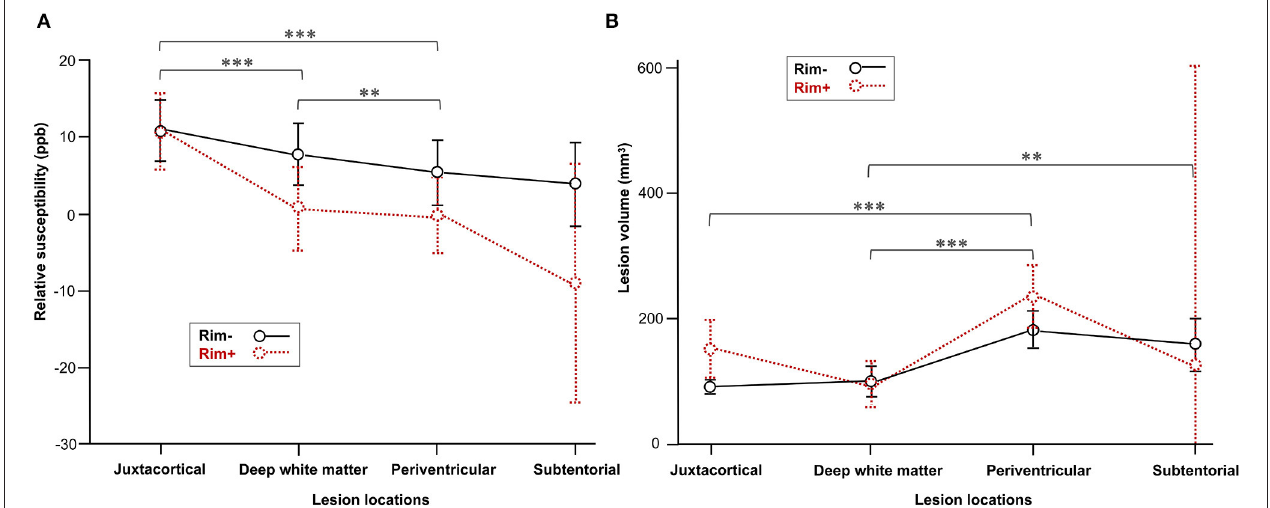
FIGURE 2 | Comparison of MS lesions in different locations. (A) Lesion susceptibility in the mixed-effects model after controlling for rim + vs. rim– status as well as lesion locations. (B) Comparison of volume in the rim + and rim– subgroups among various lesion locations. Data represent the mean (dots) and standard deviation (bars). Adjusted ** p < 0.01 and *** p < 0.001indicate significant differences between lesions in different locations.